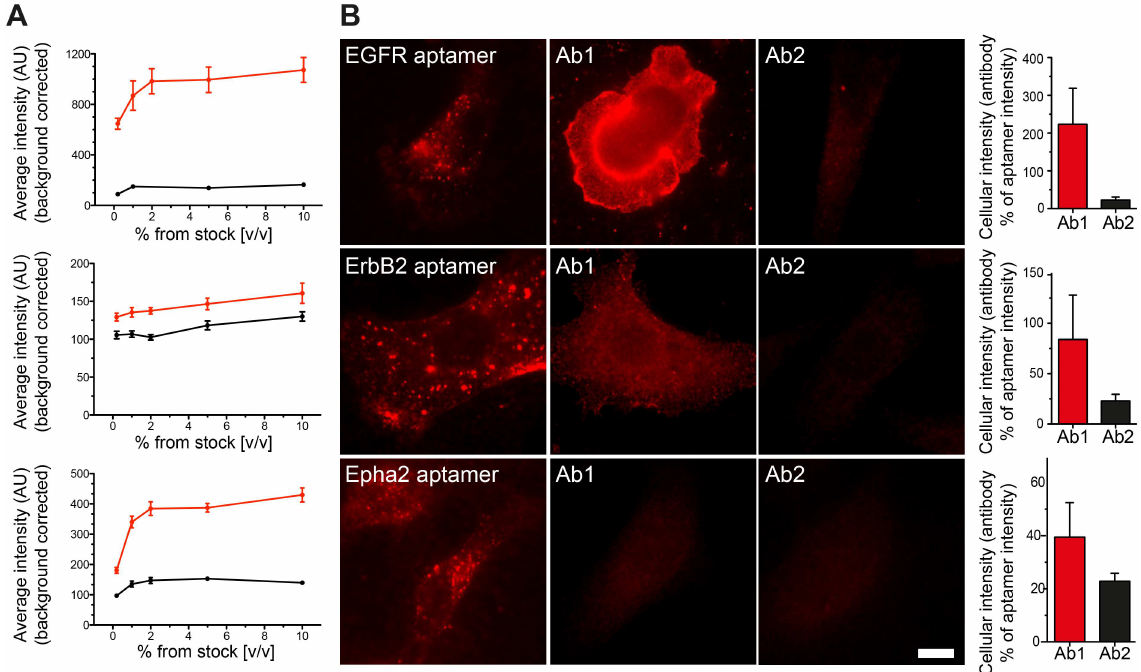
Fig 3. Direct comparison between aptamerand antibody stainings. (A) Antibody concentration was first titrated to perform optimal live-stained as explained in Fig 1A (Ab1: red trace and Ab2: black trace). Every point in the saturation curves representsthe averageintensity from 20 to 50 cells imagedwith an epifluorescence microscope from at least 3 independentexperiments (associatederror is displayedas the SEM). All further antibodystainingsthrough out the manuscript were used at 1% v/v (from the originalstock concentration providedby the supplier).( B ) Equally scaled images to allowa direct comparisonbetweenthe staining pattern, performance and fluorescence intensity of cells stainedwith aptamers or antibodies. Scale bar: 5 μ m. The bar graphs at the right of each panel show the averageintensity of cells stained with antibodies(Ab1 and Ab2) expressedin percentage of the aptamers intensities.Error bars are the SEM from 3–4 independent experiments with more than 30 cells per experiment. Detailed informationof all Ab1 and Ab2 antibodiescan be found in Table 1 in the Materials and Methods section.